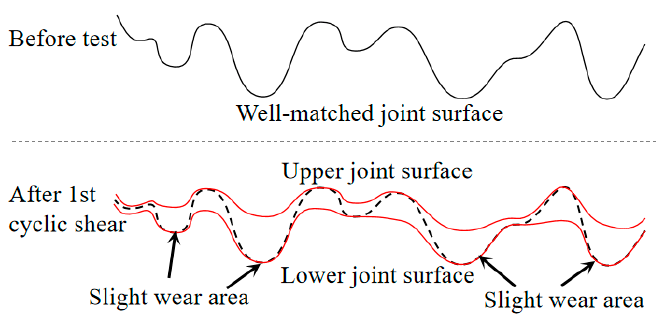
Figure 19. Local damage evolution under low normal stress.